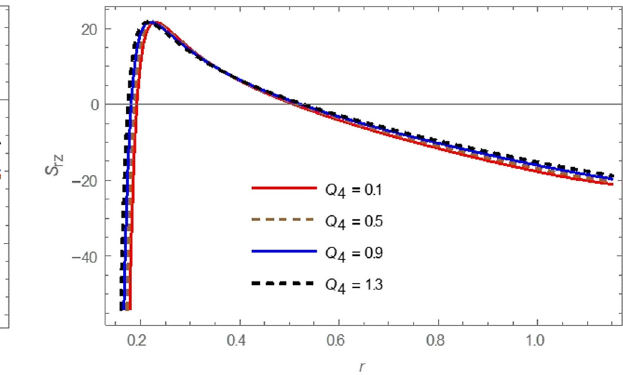
Figure 14: E ff ect of di ff erent values of stress for Q 4 on stress with